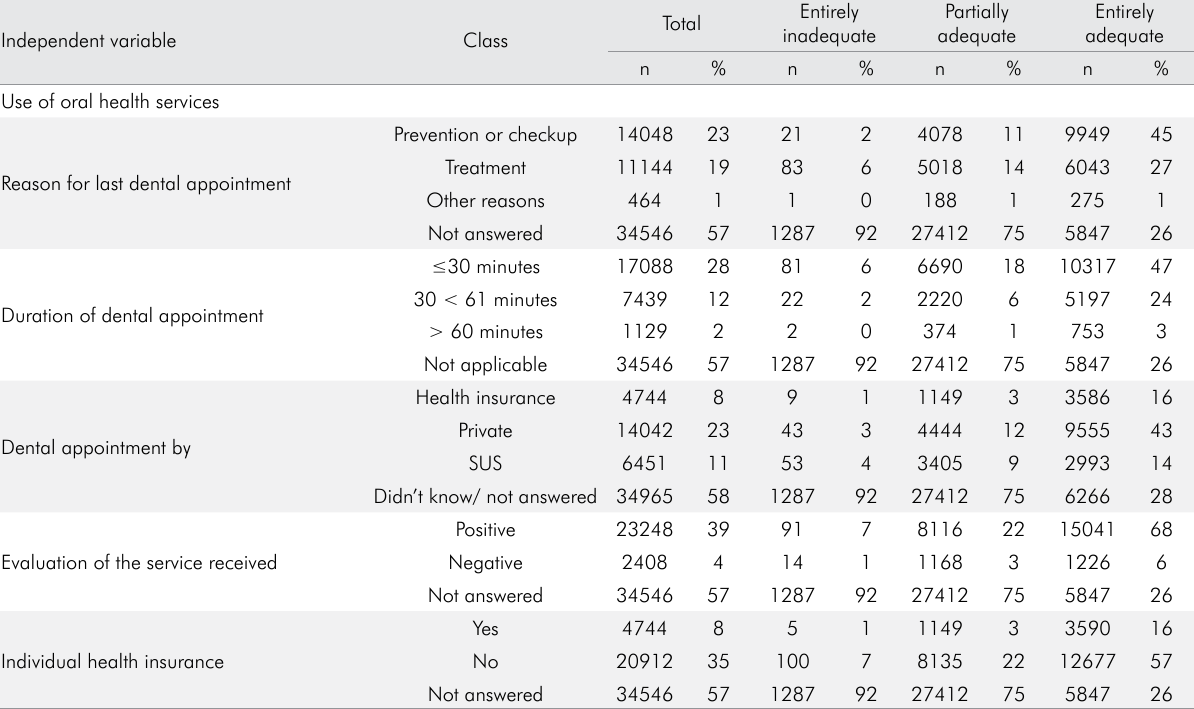
Table 3. Description of the sample, according to use of oral health services. Brazil. 2013. (n = 60202). Independent